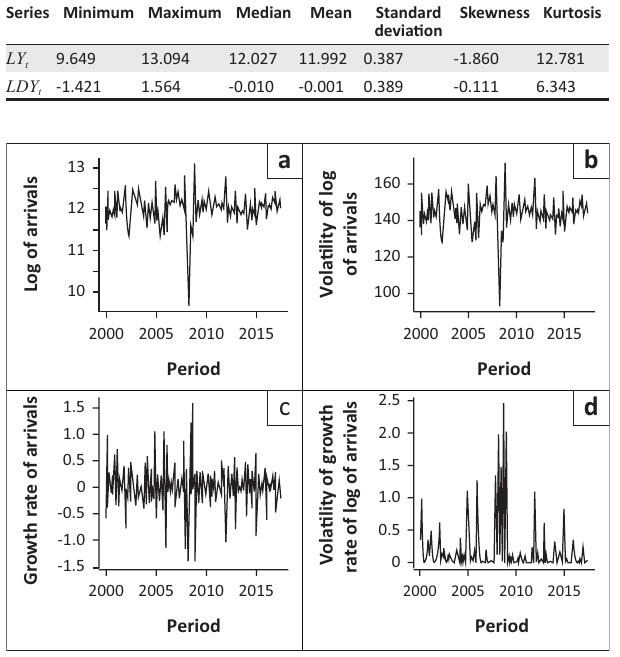
TABLE 1: Descriptive statistics of LY t and LDY t .